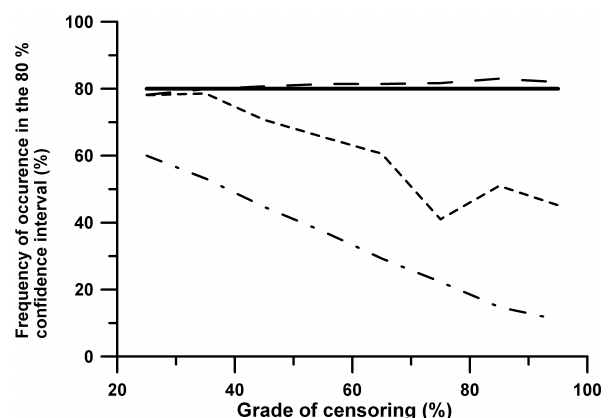
Fig.9. MeanoftheinterpolatedmapsofChloridefordifferentdegreesofcensoringanddifferentinterpolations. Fig. 9. Mean of the interpolated maps of Chloride for different degrees of censoring and different interpolations.